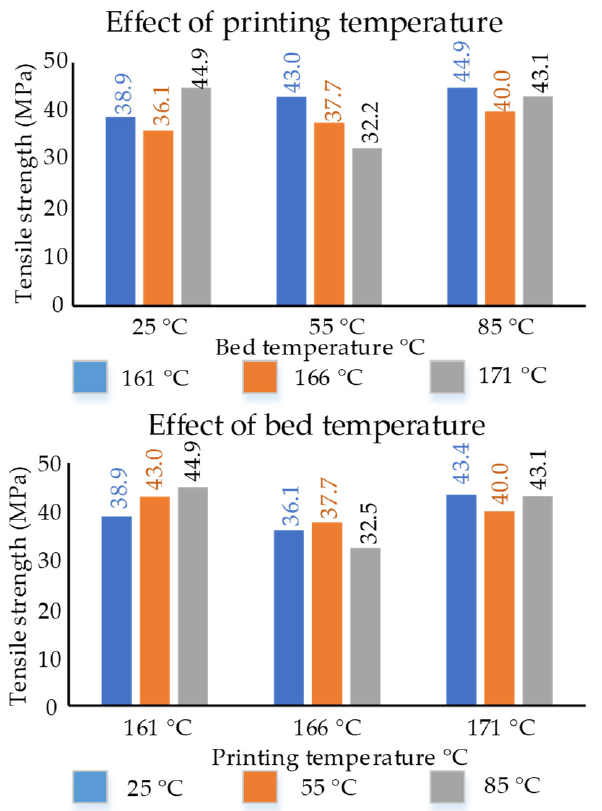
Figure 4. Effects of in-process thermal variables on tensile strength of ASTM D638 dog bones. For effects of printing temperatures at a constant bed temperature, the highest of 44.9 MPa was obtained for 171 °C at 25 °C and for 161 °C at 85 °C. At a bed temperature of 85 °C, the tensile strengths at the three printing temperatures were among the highest and also nearly similar. For effects of the bed temperature at constant printing temperatures, the highest of 44.9 MPa was obtained for 85 °C at a printing temperature of 161 °C. At a printing tem- perature of 171 °C, the tensile strength was found to be similar for 25 °C (43.4 MPa) and 85 °C (43.1 MPa). Overall, it is noted that the change in in-process thermal variables does affect the overall properties. However, at the constant high-temperature combinations of 85 °C (bed temperature) and 171 °C (printing temperature), the properties were revealed to be simi- lar. 4. Discussion 4.1. Microscopic Analysis of Melt Blending As achievement of excess physical interlocking in melt blending is the main goal in this research, therefore, the 3D-printed blend was tested for visual signs of interlocking. Furthermore, the after-effects of tensile loading on blend morphology were also observed. The images in Figure 5 reveal visible signs of polypropylene interlocked in the PLA matrix. The figure shows magnified images of the area loaded under tensile loading. The 4000-times magnified image presents two distinct morphologies. One of them is fibrous and the other is in stable beads. The fibers are probably PP as they appear distinct and